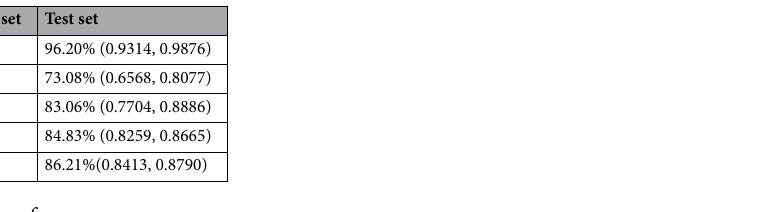
Table 2. Segmentation performance.